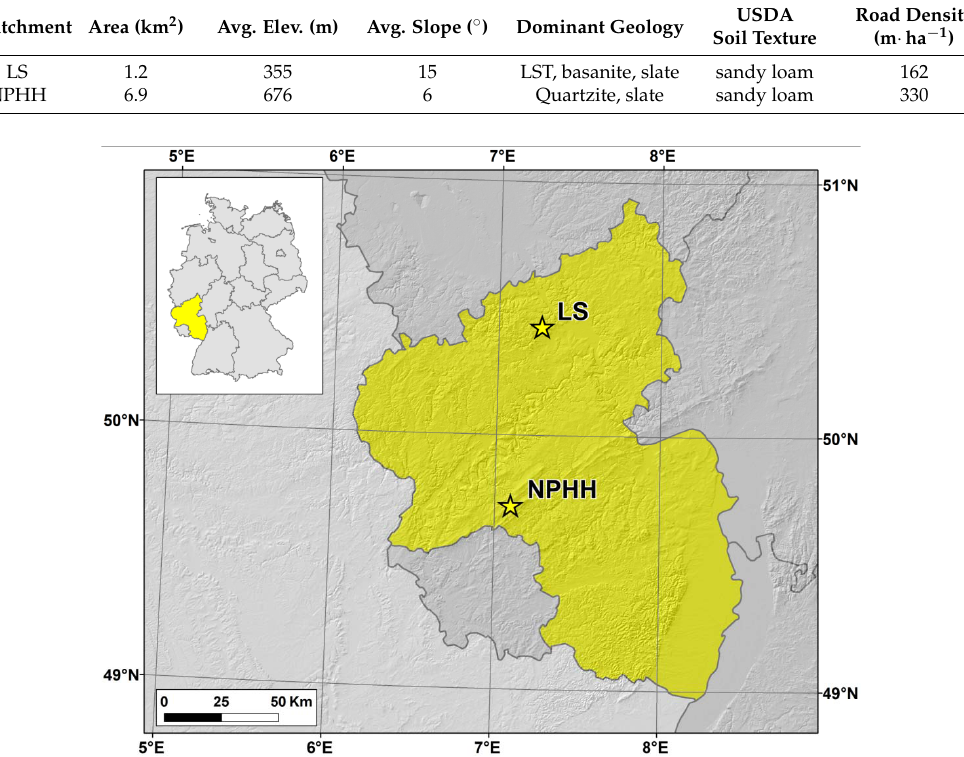
Table 1. Morphometric, pedologic and geologic characteristics of the study areas.